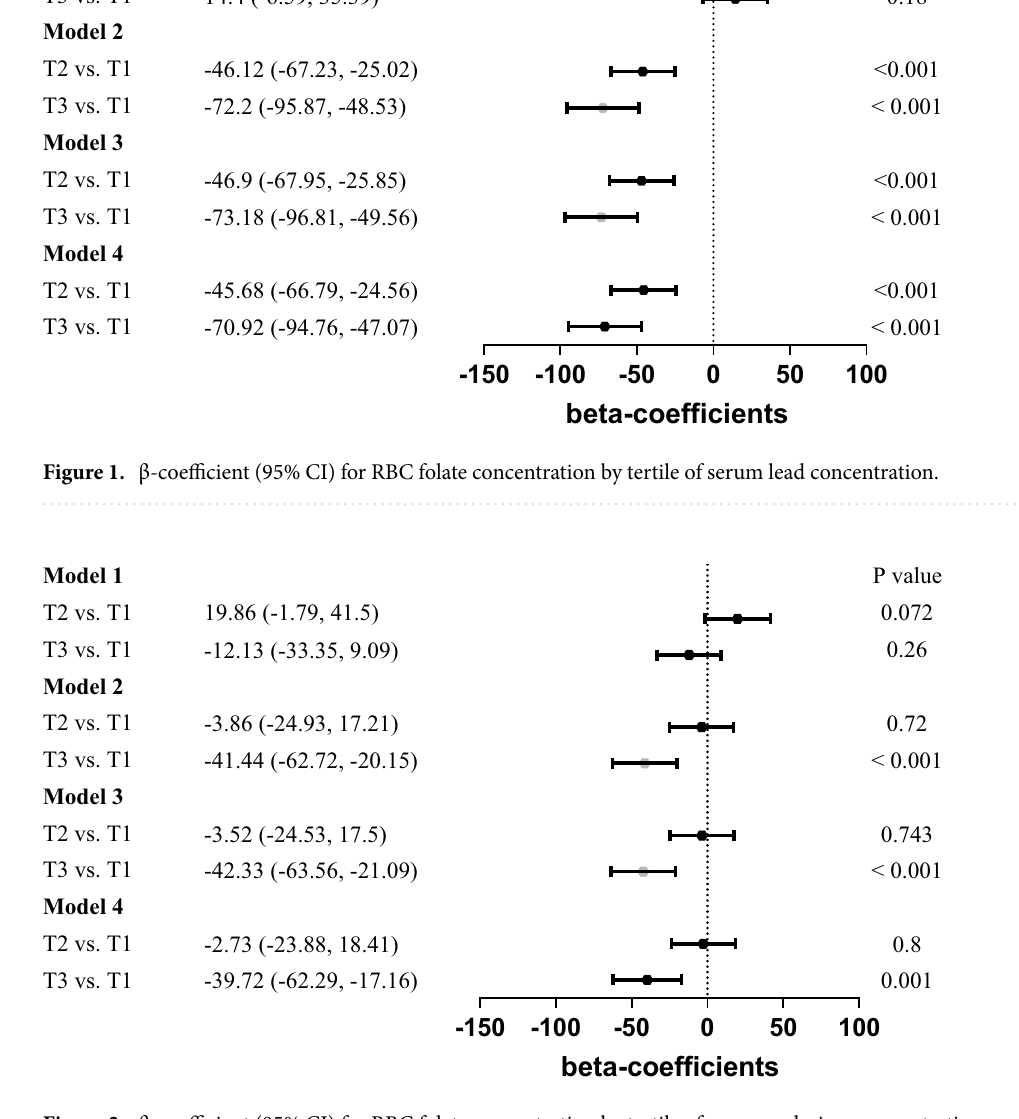
Figure 2. β-coefficient (95% CI) for RBC folate concentration by tertile of serum cadmium